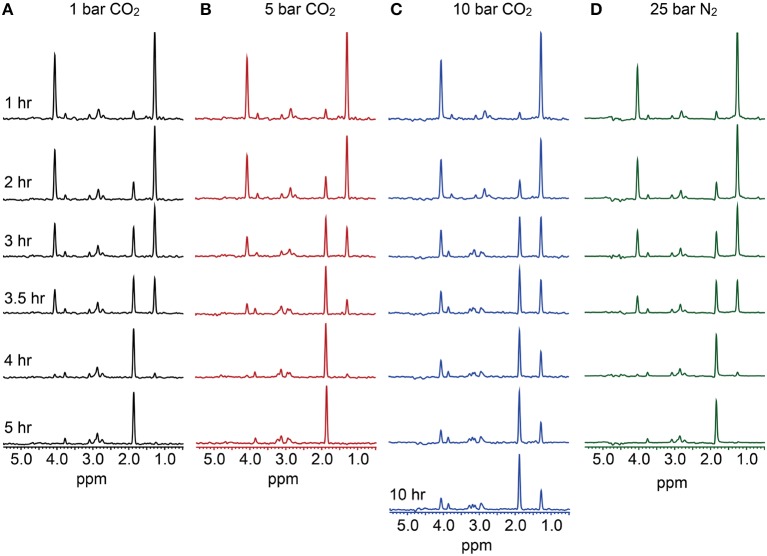
Carbon (CO2 as the pressurizing phase) and proton (N2 as the pressurizing phase) NMR data. Oxidation of 13C-3-lactate to acetate was monitored via the disappearance of lactate peaks at 4.04 and 1.26 ppm, which represent the lactate C-H and C-H3 bonds, respectively. Concurrent to this, the peak appearing at 1.84 ppm represents the acetate CH3 bond. Data indicates that at 1 bar CO2
(A), 5 bar CO2
(B), and 25 bar N2
(D), complete conversion of lactate to acetate occurs over a 4–5 h. period. At 10 bar CO2
(C) however, incomplete lactate oxidation is observed, supporting observations made in high-pressure CO2 batch experiments.